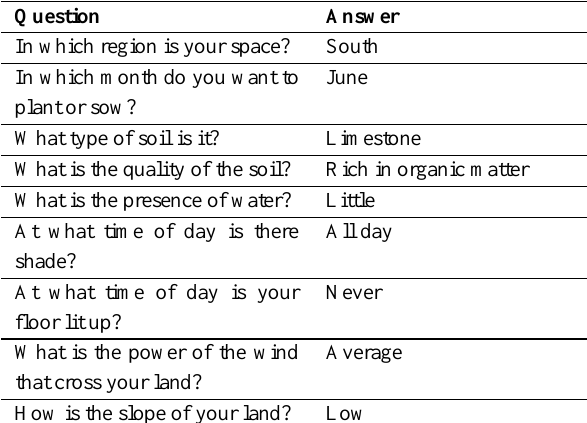
Table 12. Favourable conditions for cocoa in